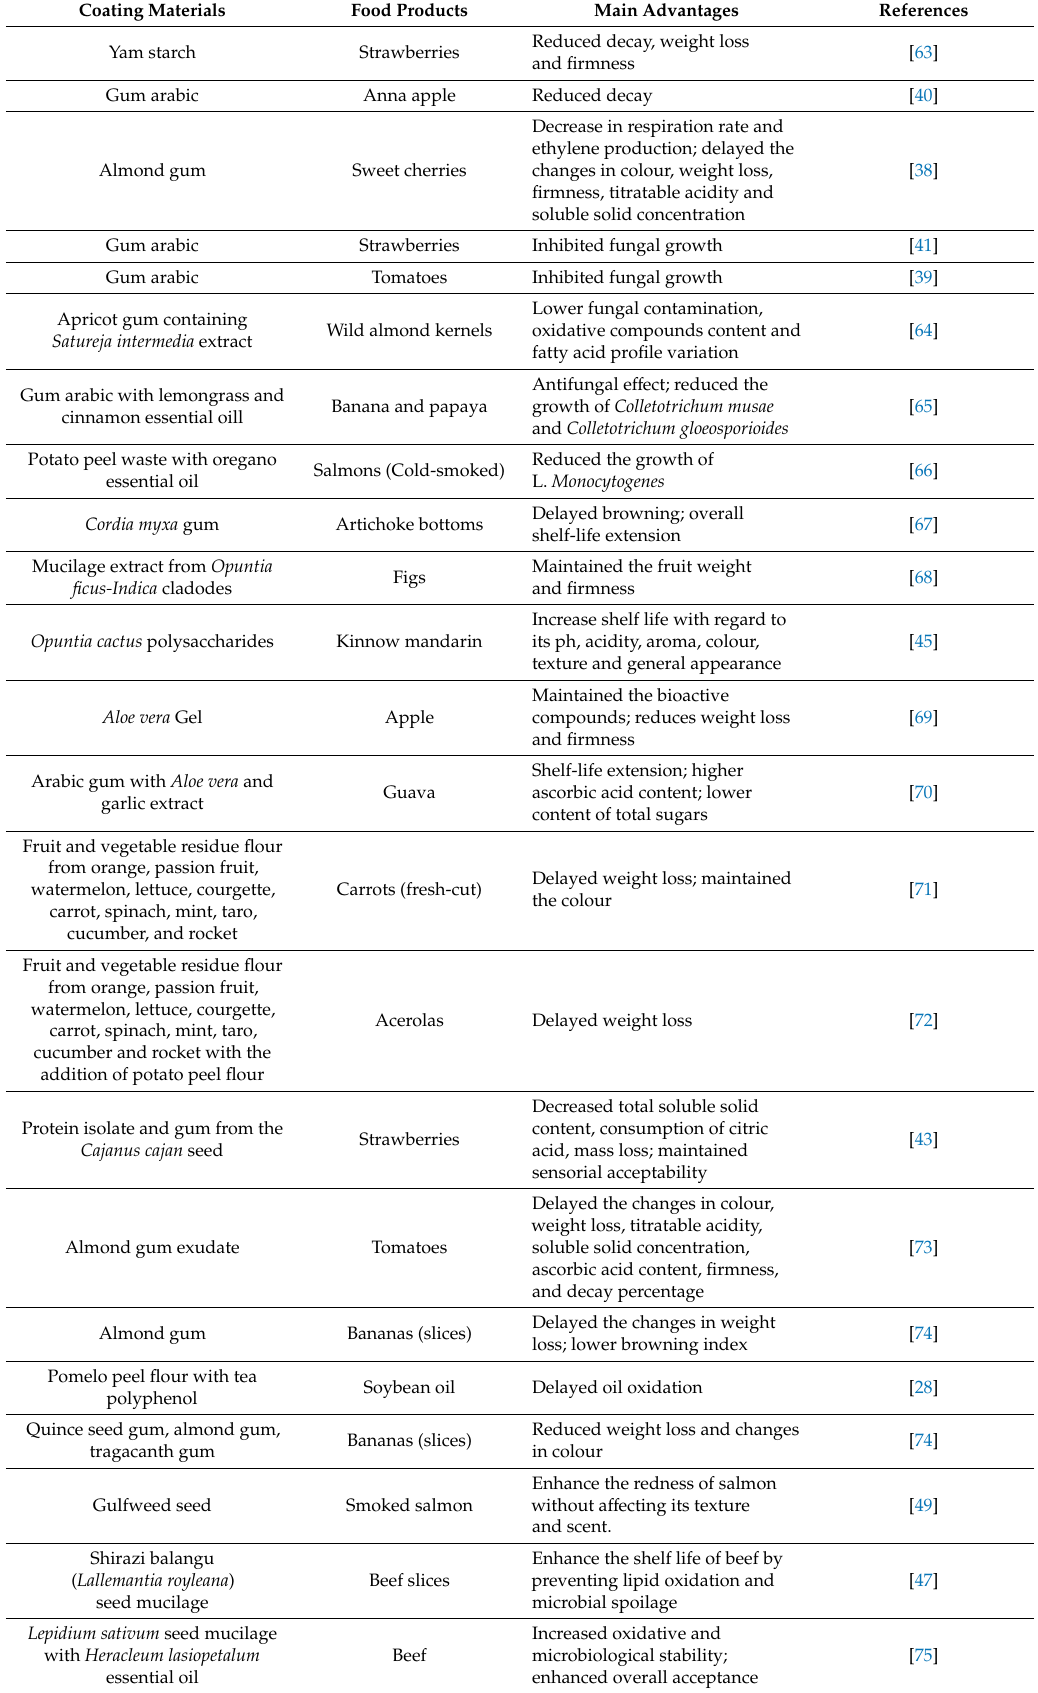
Table 3. Potential applications of novel edible